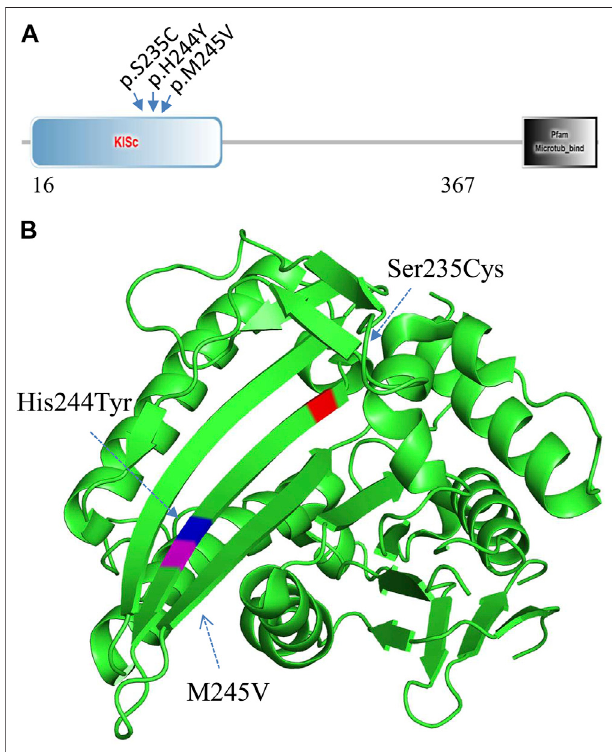
FIGURE 4 | Mutation analysis of KIF11 . (A) Three hearing-loss associatedvariants arelocatedintheKIScdomain (SmartMotif). (B) Basedon the human KIF11 kinesin domain 3D-structure (PDB, 3K5E), all the three hearing-loss associated variants are located in the same beta-sheet in the Kinesin motor domain.